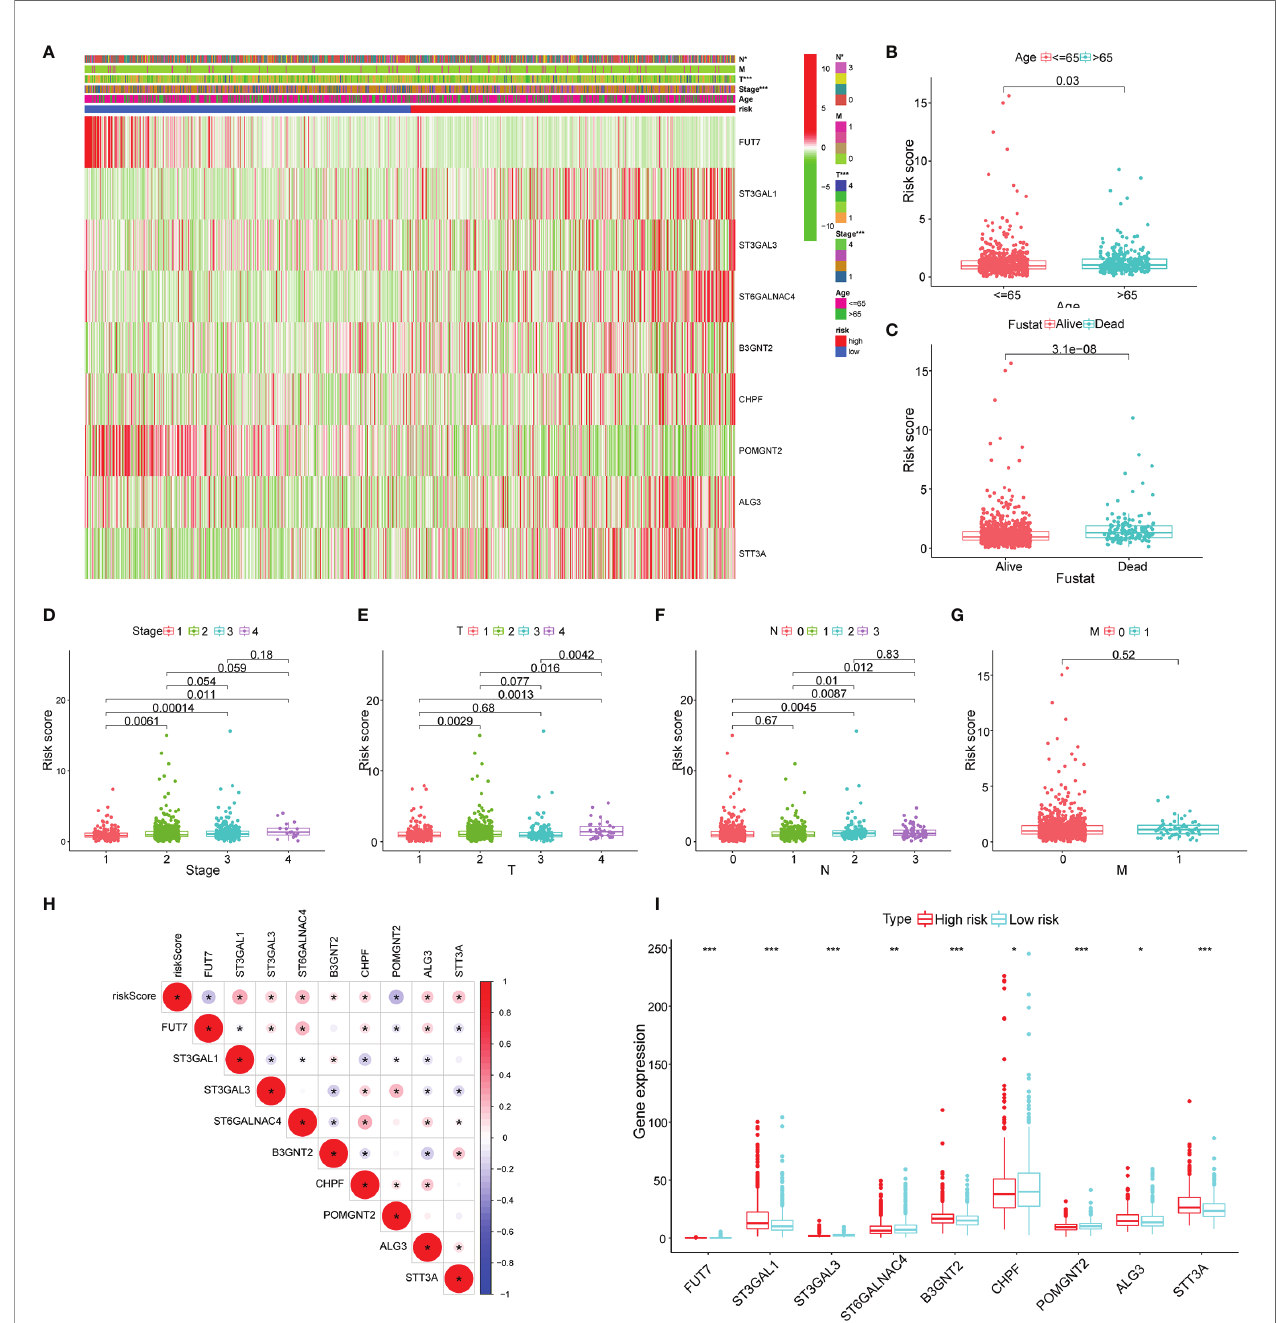
FIGURE 5 | Clinicopathological characteristics evaluation by the glyco-signature. (A) A heatmap visualizing the distribution of clinicopathological factors (age, stage, T, N, and M) and expression of 9 glycosyltransferase genes in the low-risk and high-risk groups. The scatter diagram of age (B) , survival status (C) , stage (D) , and stages T (E) , N (F) , and M (G) between groups of high and low risk. (H) The correlation of the 9 glycosyltransferase genes with the risk score. (I) The expression of 9 glycosyltransferase genes between high- and low-risk groups. *p < 0.05, **p < 0.01, ***p <